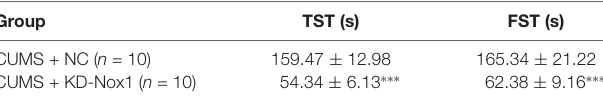
TABLE 3 | Effects of Nox1 knockdown on the behavioral functions of CUMS mice. Group TST (s) FST (s)